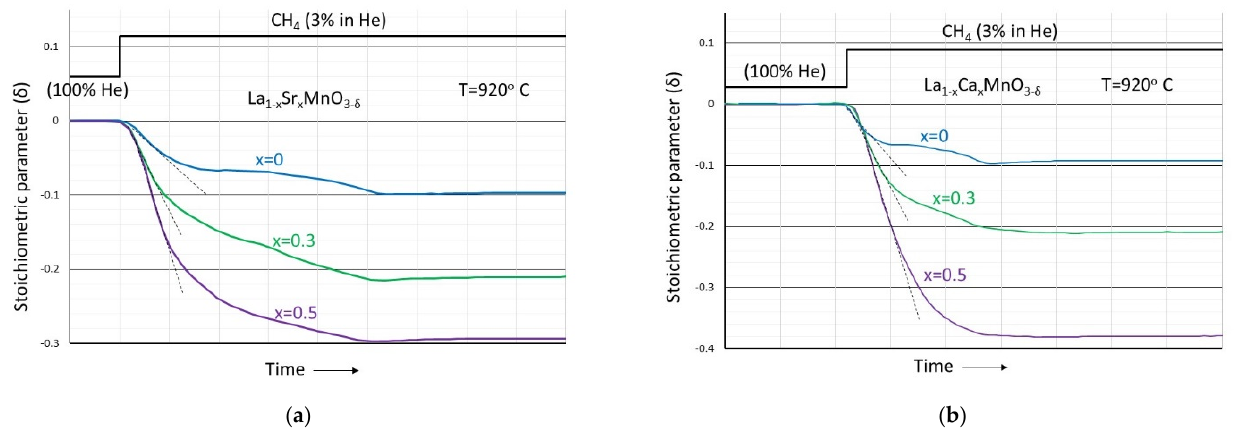
Figure 7. The dependence of the stoichiometric parameter δ in ( a ) La 1-x Sr x MnO 3- δ and ( b ) La 1-x Ca x- MnO 3- δ , initially equilibrated in helium and subsequently subjected to a gas mixture of 3% CH 4 in helium, as a function of divalent ion content x at constant temperature of 920 °C.